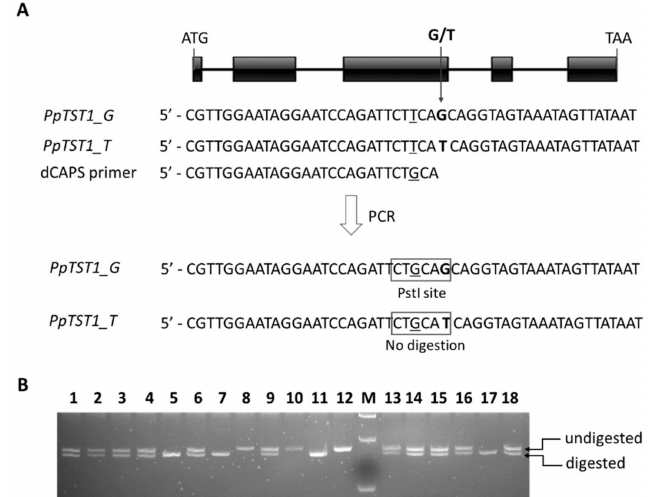
Figure 2. Development and application of gene-tagged molecular marker. ( A ) derived Cleaved Amplified Polymorphic Sequence (dCAPS) marker development for PpTST1 . The G / T single nucleotide polymorphism (SNP) is highlighted in bold. The underlined character indicates the mismatched base for introducing the dCAPS marker. ( B ) genotyping of peach cultivars with the dCAPS marker. PCR products of each cultivar was digested with PstI and then separated on agarose gel. 1, PANDANA; 2, Diwang 1; 3, Gubatiantao; 4, Hongburuan; 5, 97-1-1; 6, Jinxiayoupantao; 7, Frederica; 8, Hanyin 22; 9, GHETA; 10, Asama Hakuto; 11, Lianhuang; 12, Zheng 97-4-51; 13, 4-3-3; 14, 99-13-9; 15, Xiahui 6; 16, Zhongyoupantao 2; 17, Meiguowanyou; and 18, Ruiguang 19. M, DNA ladder.